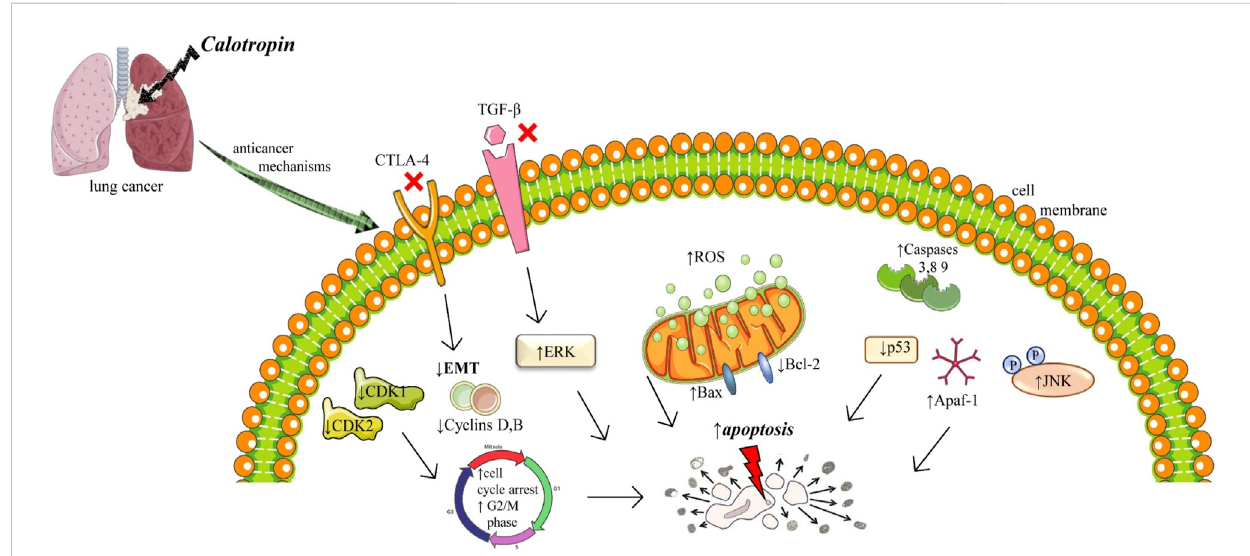
FIGURE 2 Illustrative scheme with cytotoxic mechanisms of Calotropin in lung cancer. Abbreviations and symbols: ↑ increase, ↓ decrease, Epithelial- mesenchymal transition (EMT), Reactive oxygen species (ROS), mitogen-activated protein (MAP) kinases and cJun NH2-terminal kinase (JNK), transforming growth factor β (TGF- β ), cytotoxic T-lymphocyte – associated antigen 4